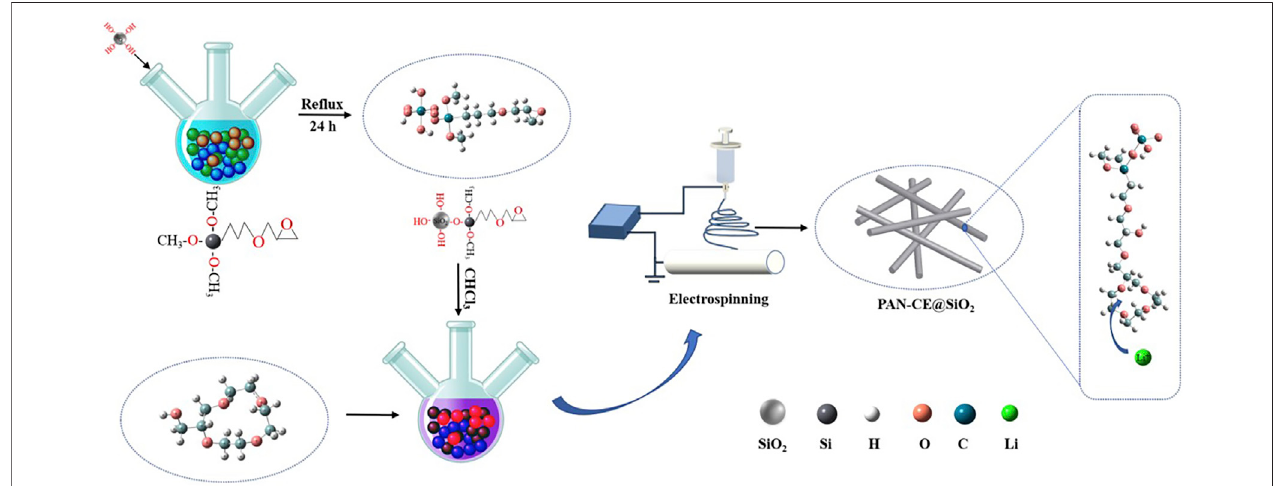
FIGURE 1 | Synthetic route of PAN-CE@SiO 2